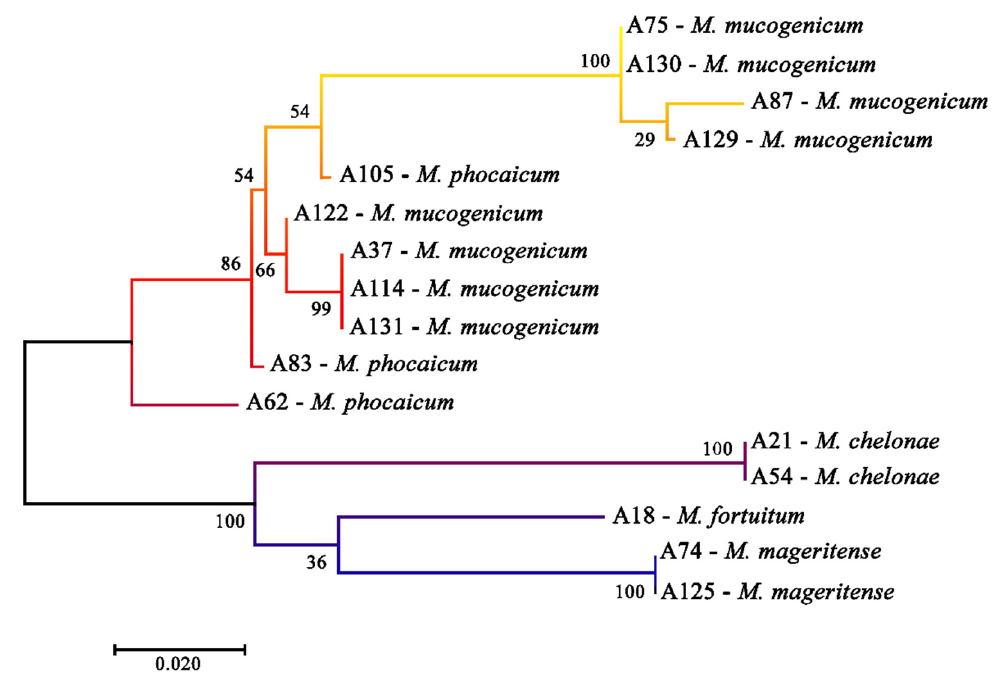
Figure 2. Molecular phylogenetic analysis by maximum likelihood method.